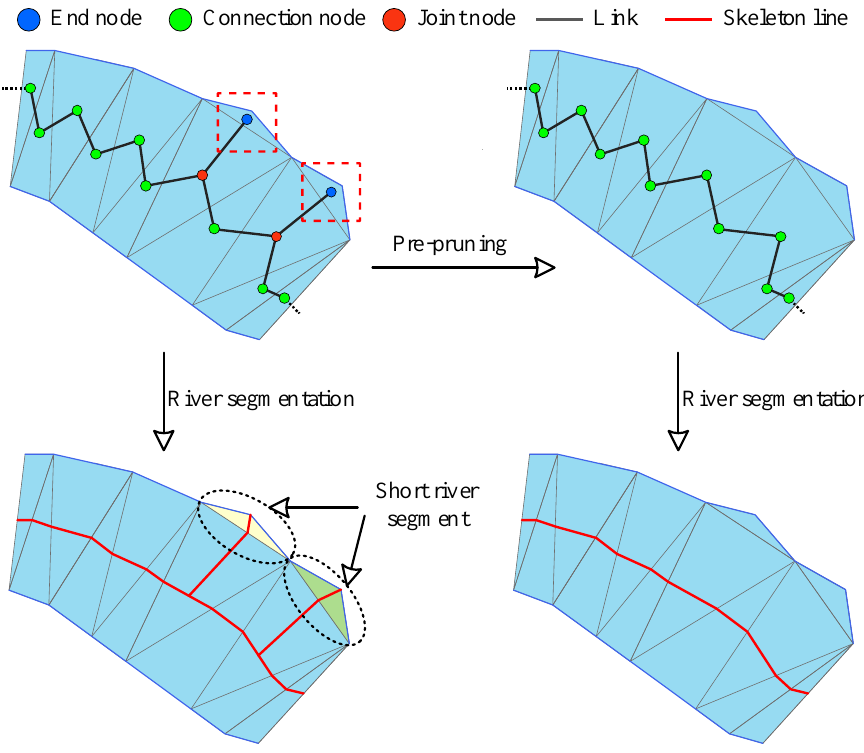
Figure 4. Comparison of the skeleton graph before and after pre-pruning .